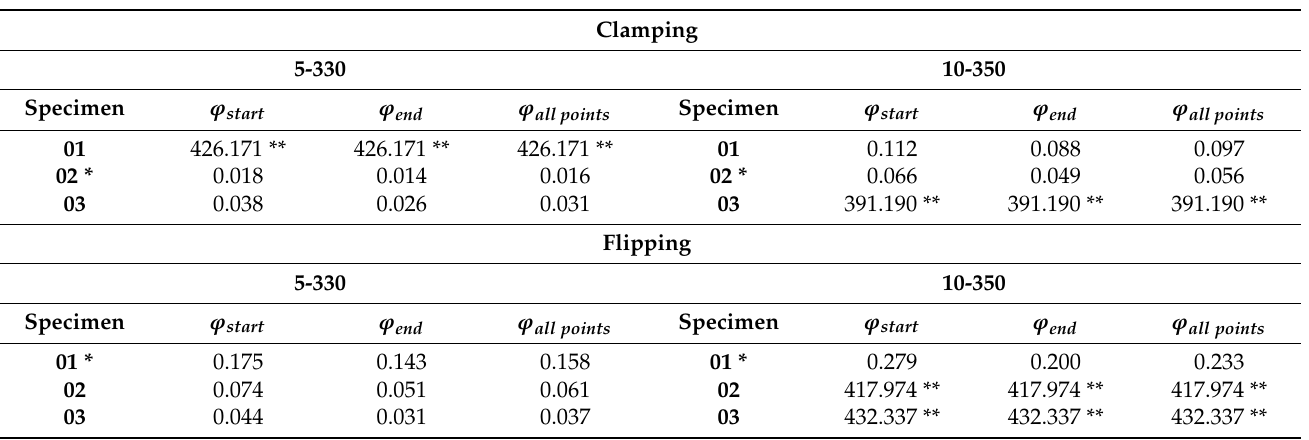
Table 4. ϕ calculated using ∆ start , ∆ end , and ∆ all points for clamping- and flipping-specimens tested under fatigue mode I loading.